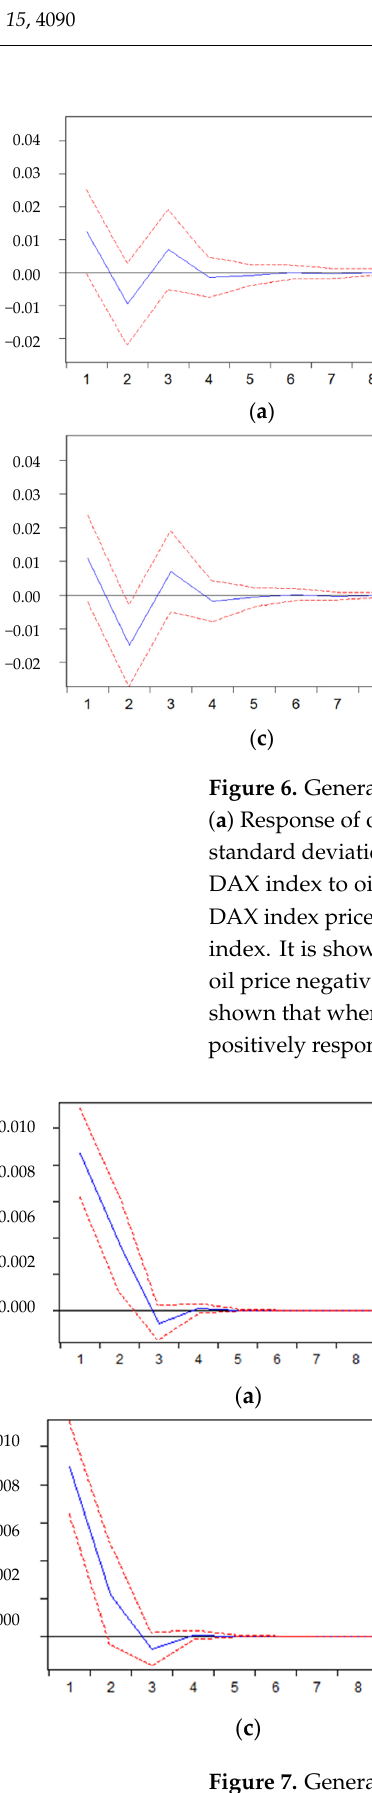
Figure 7. Generalized impulse response functions (post-vaccine period for oil-exporting countries). ( a ) Response of oil to the RTS index. It is shown that when the RTS index price is shocked by